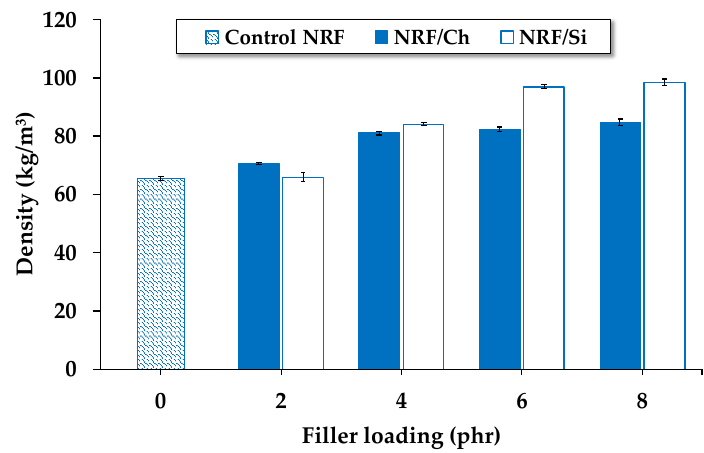
Figure 1. E ff ect of filler loading on the density of the NRF samples. Figure 1. Effect of filler loading on the density of the NRF samples. Figure 1. Effect of filler loading on the density of the NRF samples.